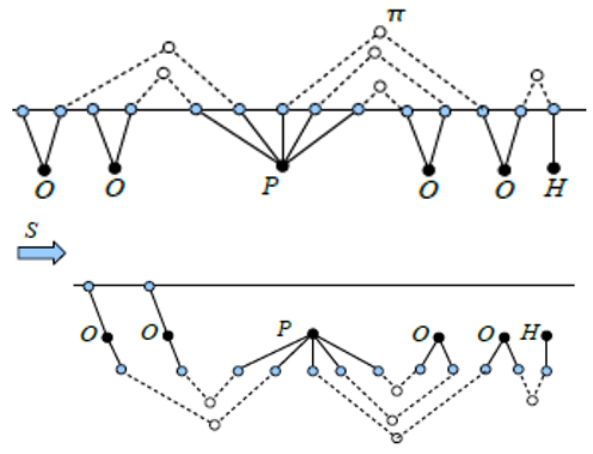
Fig. 3. Convolutions for ethylene For the aromatic bond, a convolution with six (for benzene) and a large number of H atoms (for other aromatic hydrocarbons) is selected.